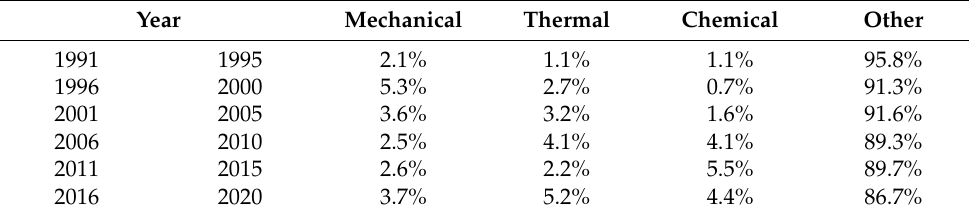
Table 6. Distribution of backward mechanical recycling citations per type of patent cited.